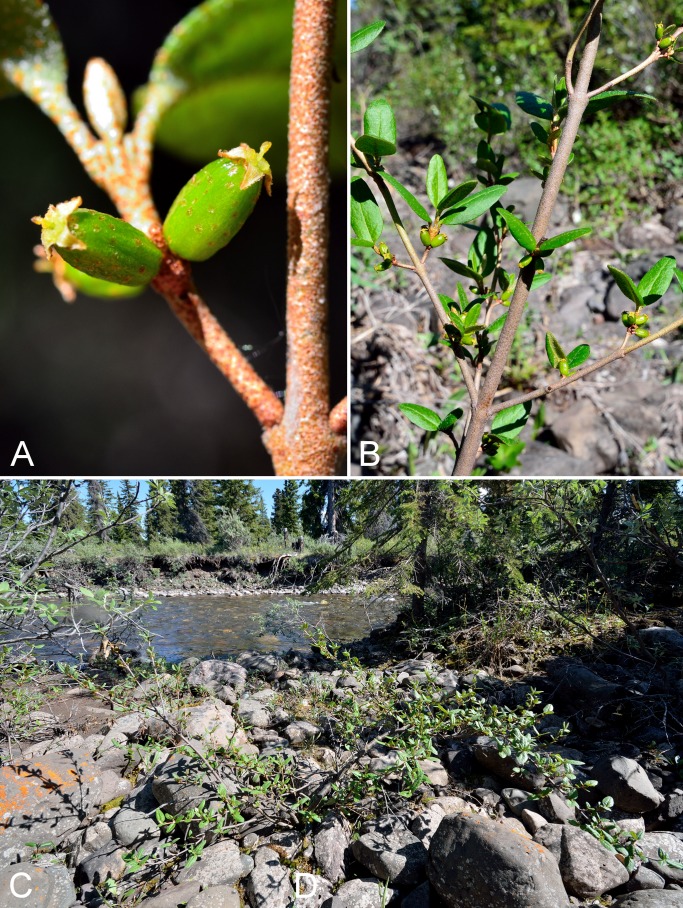
Shepherdia canadensis.(A) Fruits, Saarela et al. 3148. (B) Habit, Saarela et al. 3148. (C) Habitat, Saarela et al. 3148. Photographs by R. D. Bull.